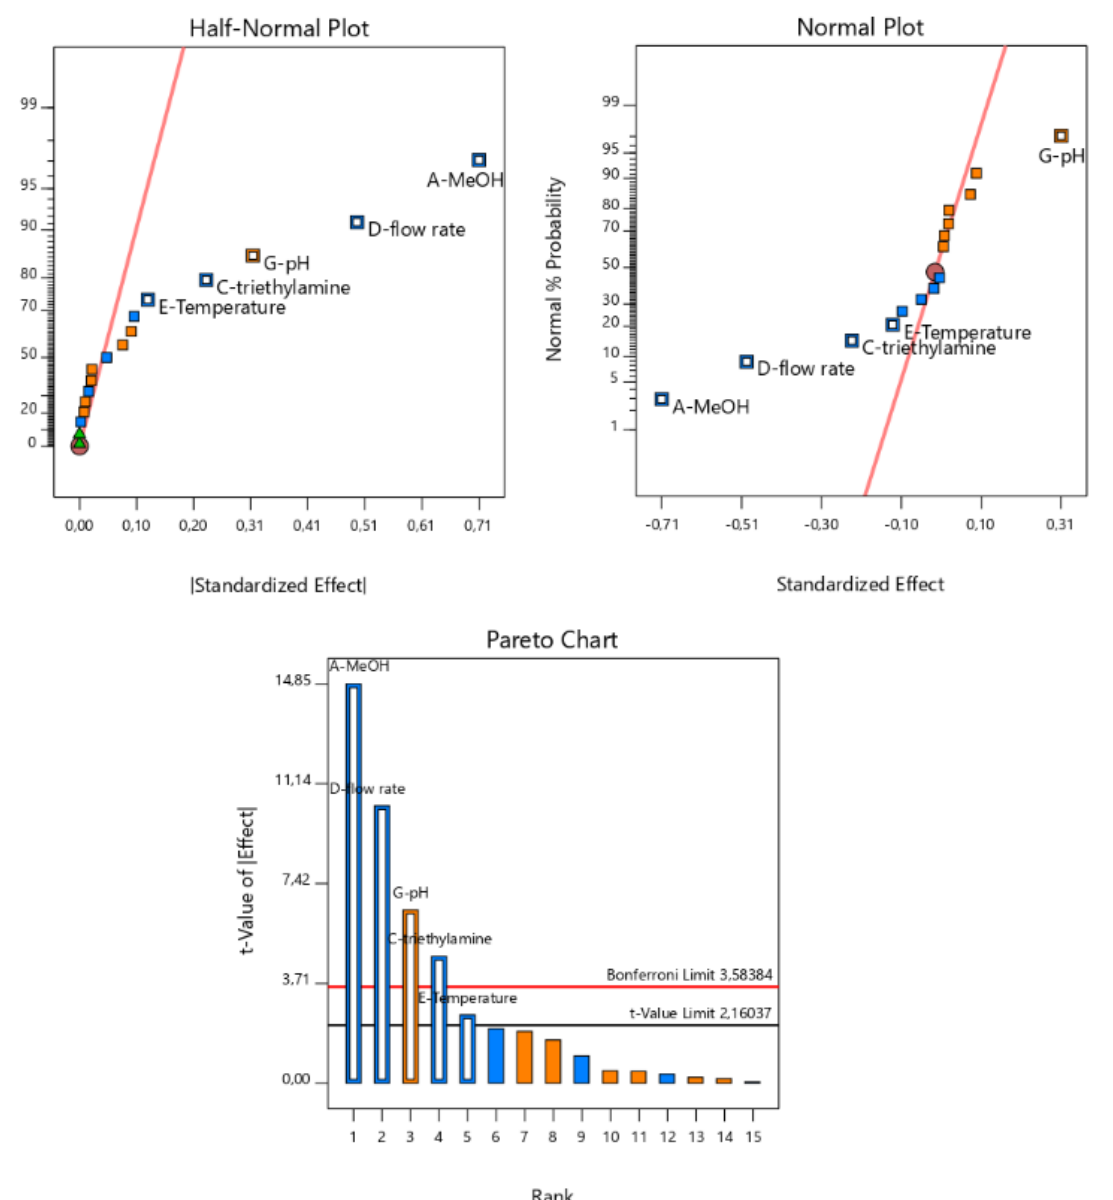
Figure 2. Representative halfnormal and normal plots (top) and Pareto chart (bottom) showing the statistically significant effects of factors for R s .